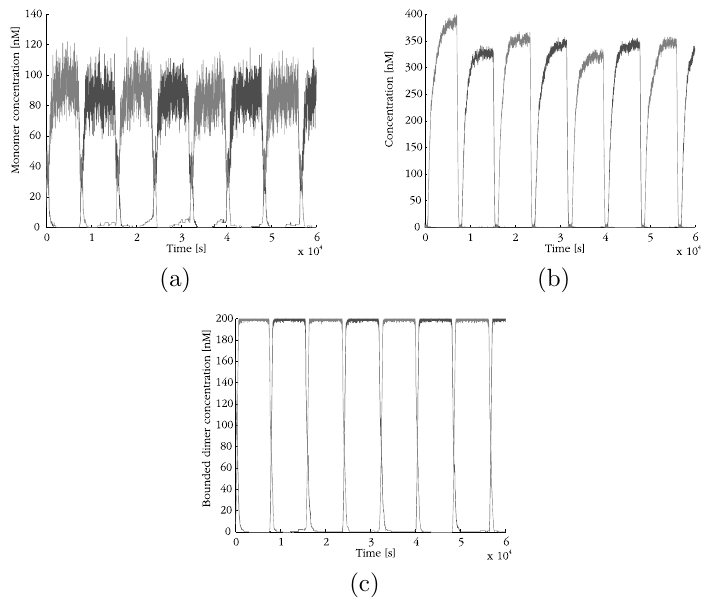
Figure 3. Time evolution of concentration of three groups of chemical species which present potential candidates that could encode the information in RS flip-flop biological equivalent. Figure (a) presents the concentration of monomers, Figure (b) concentrations of dimers and Figure (c) concentrations of pair of proteins bounded to DNA of complementary protein. Concentrations of the chemical species that are directly associated with protein X are presented with dark-grey line and concentrations of the chemical species that are directly associated with protein Y with light-grey